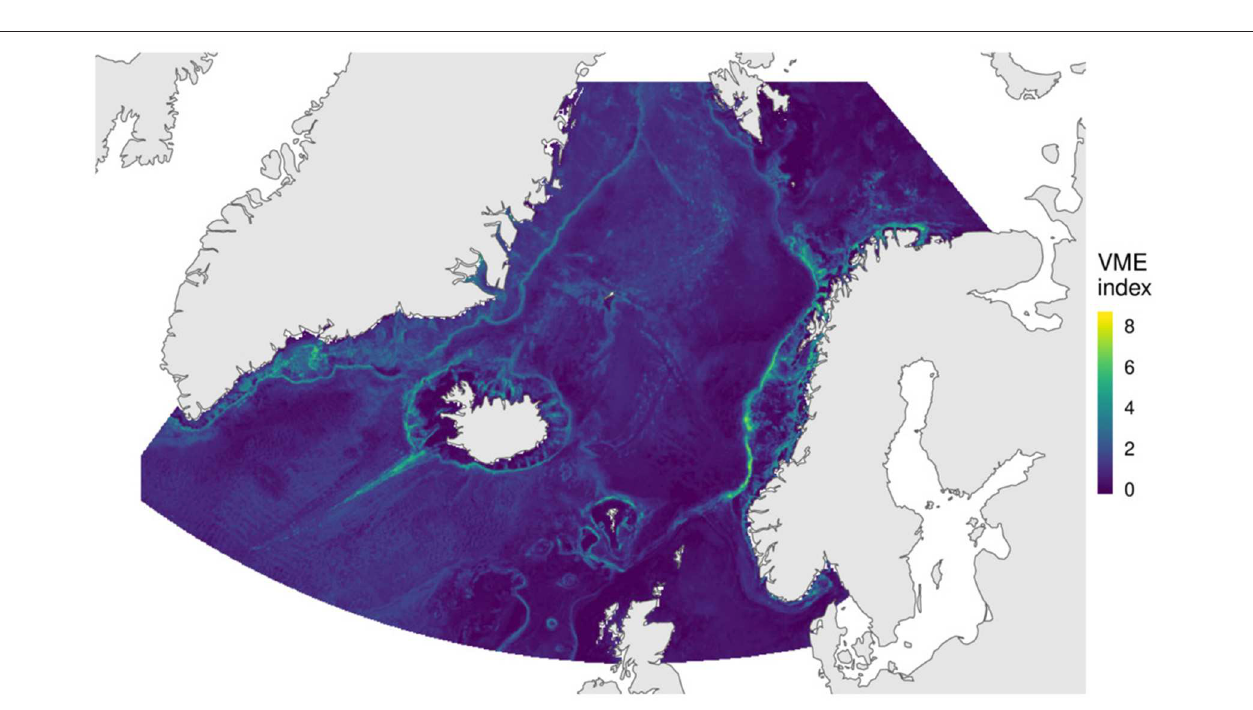
(2015) and urge caution when using the output of these models for management purposes. Modeled distributions should be used not as evidence of the presence of VMEs, but rather as a data- driven approach to identify areas where the presence of these habitats is likely (Hourigan,